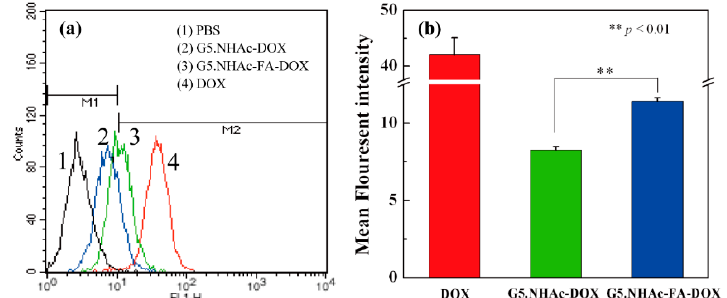
Figure 6. Flow cytometry analysis of ( a ) the in vitro cellular uptake of free DOX (10 μ M), G5.NHAc-DOX and G5.NHAc-FA-DOX with a DOX concentration of 40 μ M in KB cells after 2.5 h incubation and ( b ) the mean fluorescence intensity of KB cells after 2.5 h treatment. KB cells treated with PBS were set as control.